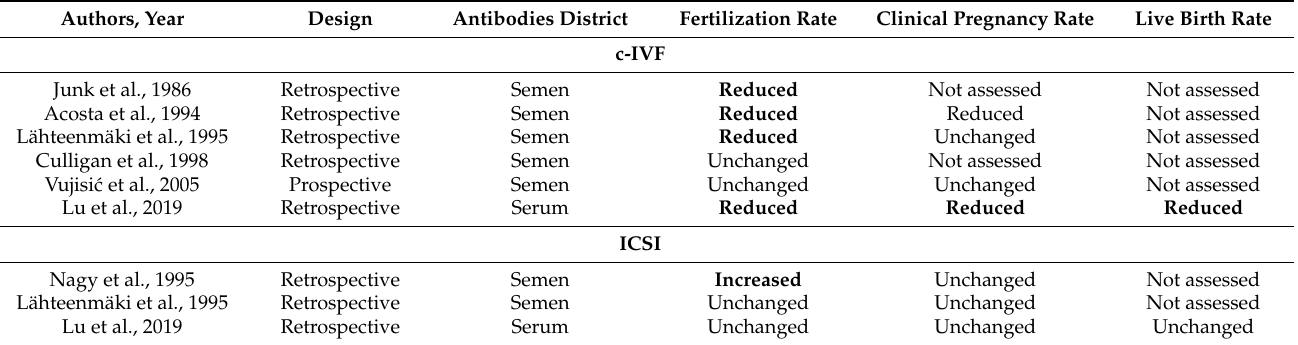
Table 3. Findings of studies investigating outcomes in couples with ASA-positive male partners compared to ASA-negative male partners following c-IVF and